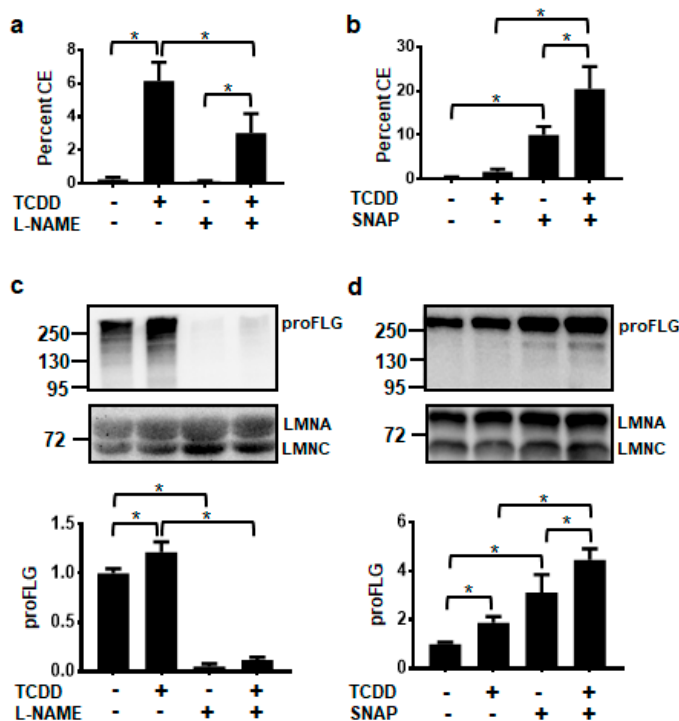
Figure 3. AHR-mediated keratinocyte differentiation is decreased by the NOS inhibitor, L -NAME (1 mM) ( a , c ) and increased by the NO donor, SNAP (100 μ M) ( b , d ). Percent cornified envelope (CE) formation ( a , b ) (mean ( n = 4) +/- SD) was measured in NHEKs treated as indicated for 5 days. Levels of unprocessed FLG protein, proFLG, ( c , d ) (mean ( n = 3) +/- SD) were measured in NHEKs treated as indicated for 72 h. Protein was quantified by densitometry, normalized with levels of LMNA, and plotted relative to DMSO, set to a value of one ( c , d , lower panels). The numbers to the left correspond to molecular weight markers in kilodaltons. * indicates a significant difference, p < 0.05. Data were analyzed using two-way ANOVA followed by Tukey’s post hoc tests. These results were replicated in NHEKs from a different source.